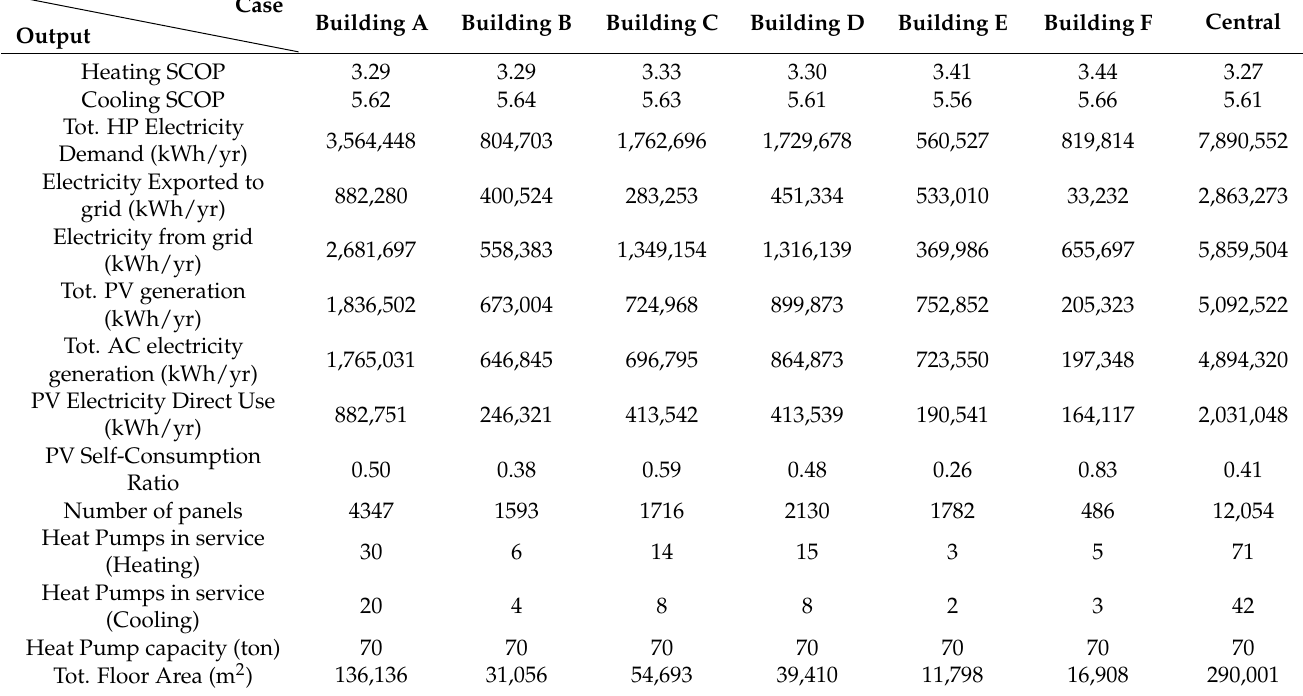
Table 5. ESM result summary for 7